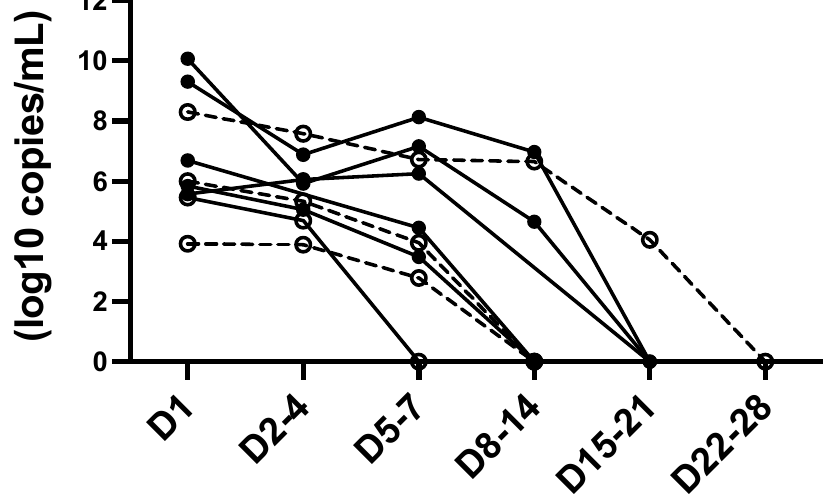
Figure 2. Serial SFTSV viral load in patients with SFTS. Open circles with dotted lines represent the SFTS patients without GGO in chest CT at admission. Filled circles with solid lines represent the SFTS patients with GGO in chest CT at admission. Days (D) after admission are displayed on X-axis. Abbreviations: SFTSV, severe fever with thrombocytopenia syndrome virus.